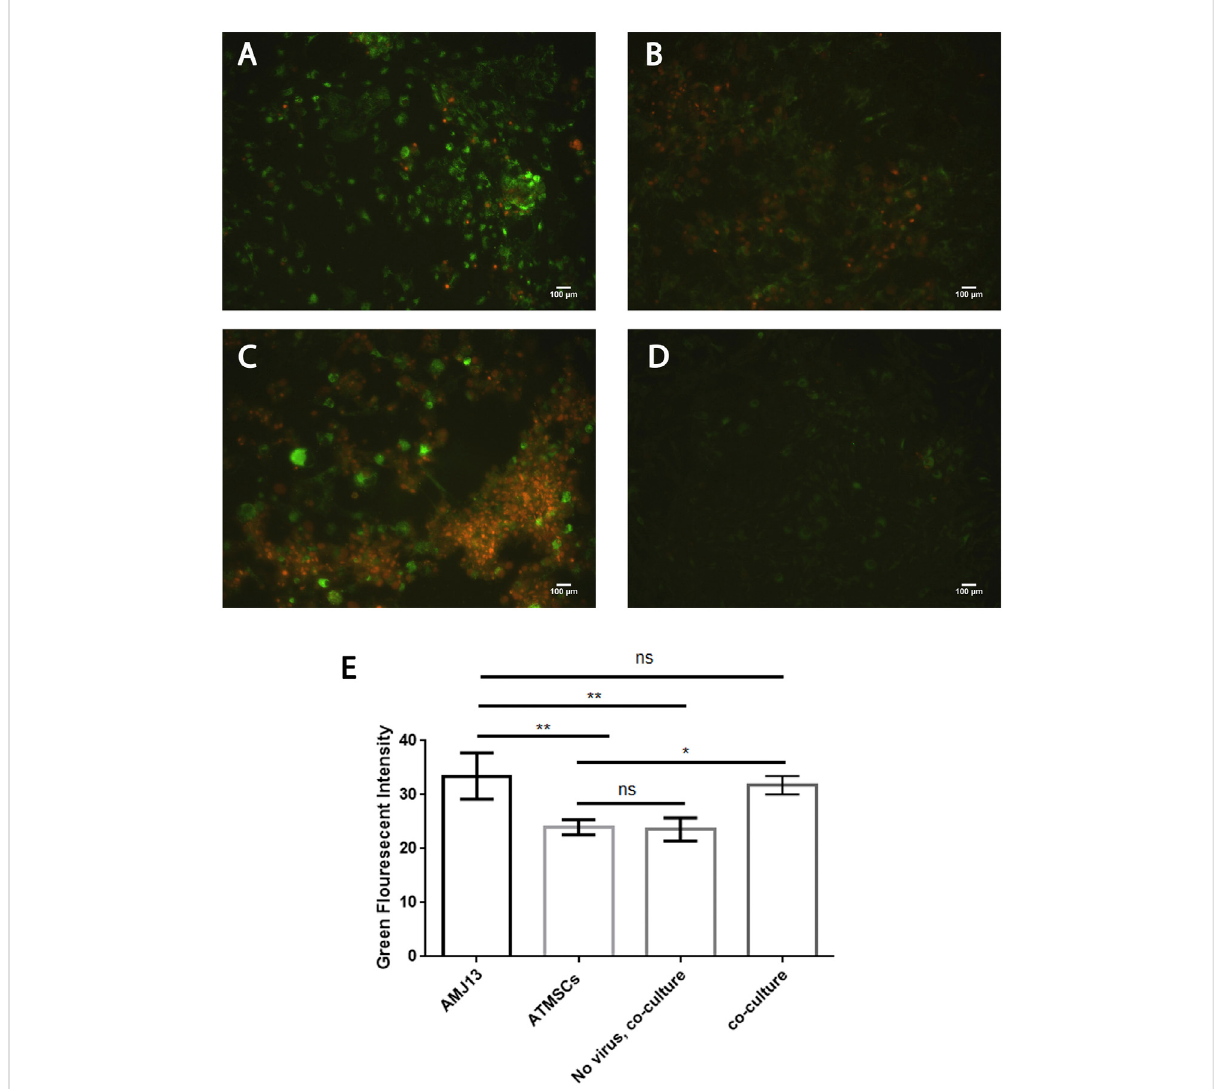
Newcastle disease virus infects and replicates in AMJ13 breast cancer cells while infecting but not replicating in normal hATMSCs. (A) AMJ13 breast cancer cells infected with labeled NDV. (B) Human normal stem cells infected with labeled NDV. (C) Coculture of AMJ13 cancer cells with human normal stem cells infected with labeled NDV. (D) Coculture model stained with PHK67 dye showing hardly detectable green fl uorescence. (E) The quantitative image analysis for green fl uorescence by ImageJ con fi rmed signi fi cant green fl uorescence intensity of infectedcancercellswhencomparedtonormalinfectedcellsandthenoninfectedcoculturecellmodel.Therewasnosigni fi cantdifferenceingreen fl uorescence intensity seen between the infected cancer cells and infected cocultured cells. Propidium iodide was used as the